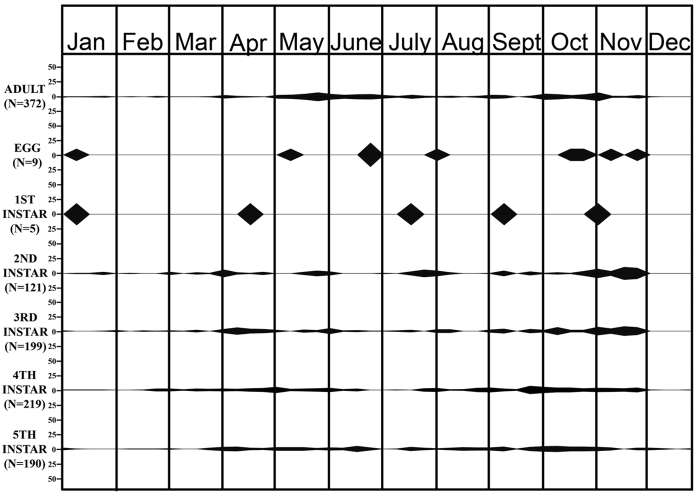
Field life cycle of M.major. Percentage in each sample of total individuals of same stage collected during 2005-2007 in Las Cruces, NM. Beginning and end points of each shaded area represent sample dates preceding and following collections of specimens, respectively.